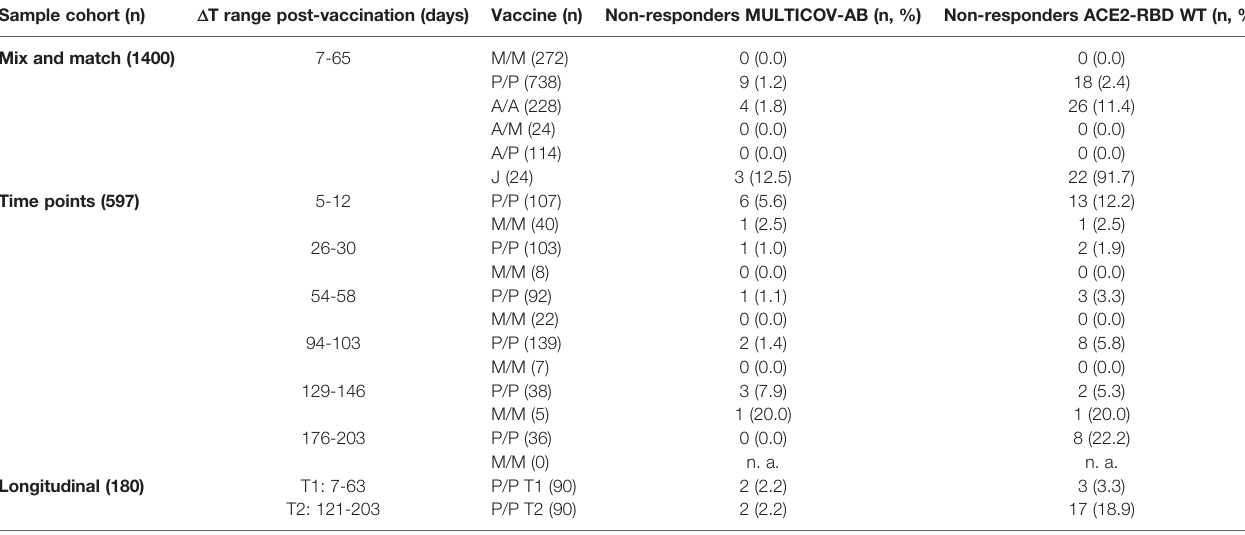
TABLE 2 | Vaccine non-responder rates across study population. Sample cohort